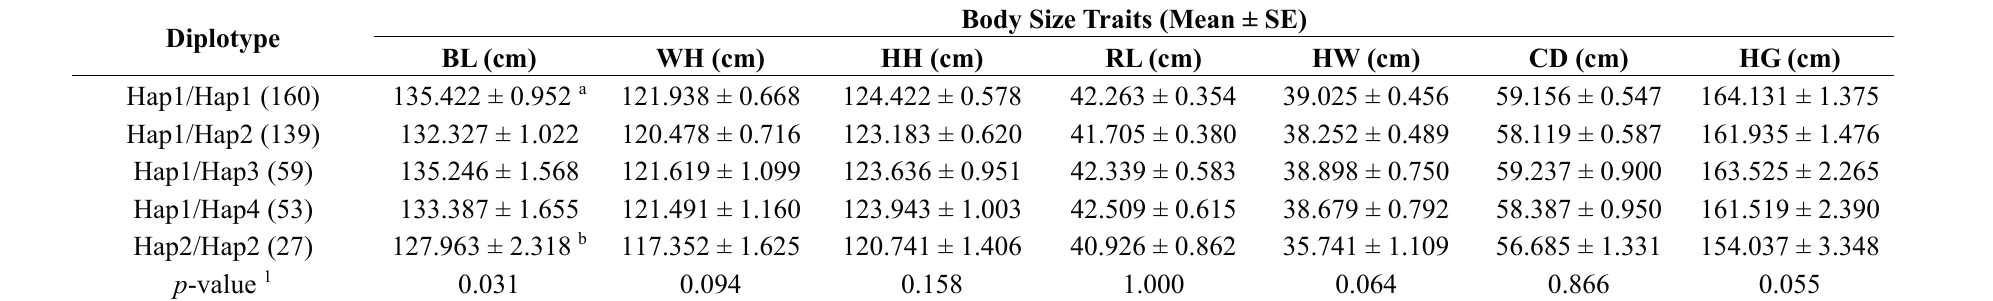
Table 5. Associations of daplotypes with body size traits in Qinchuan